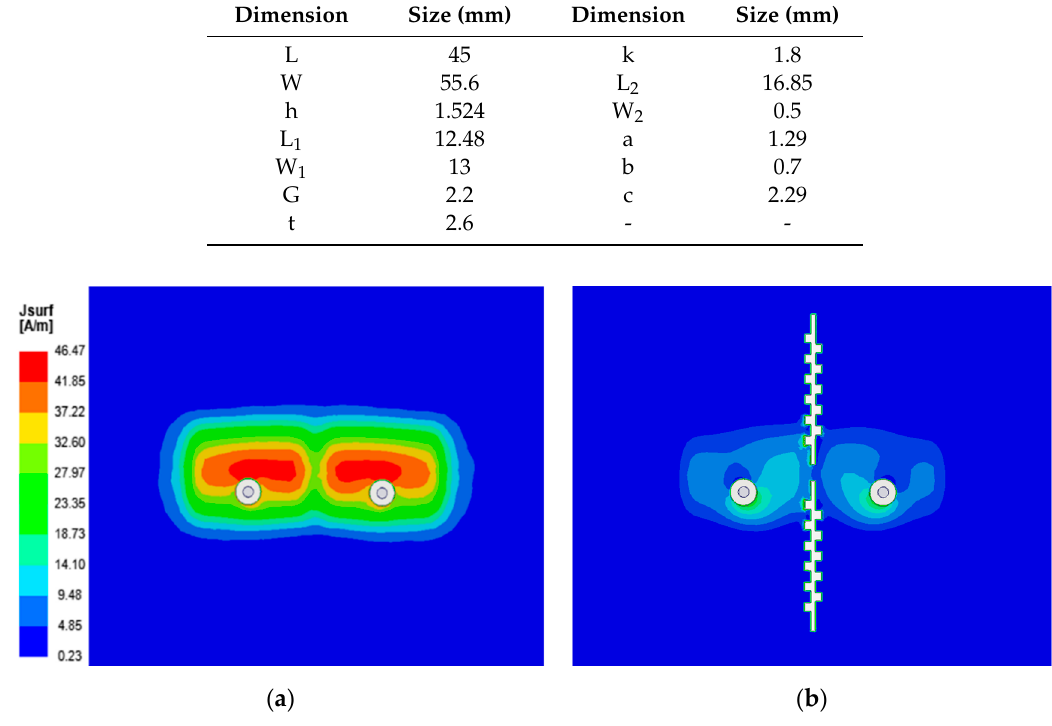
( b ) Figure 12. Operation frequency at 5.8 GHz. The radiation pattern of MIMO antenna with and without DGS. ( a ) E plane; ( b ) H plane. 4. Measurement Results and Discussion As previously discussed, by using the electromagnetic simulation tool, HFSS, the performance of designed DGS in a MIMO antenna has been carried out, in terms of working bandwidth, reflection coefficients, mutual coupling, radiation pattern, and gain. This designed MIMO antenna with DGS was fabricated in our laboratory and must be checked in experiment. A photograph of the sample is shown in Figure 16, together with the microwave chamber and antenna test system. The overall size of this antenna is W × L × h = 55.6 × 45 × 1.524 mm. Other dimensions in Figure 2 and the preferred physical sizes as selected in the above discussion are listed in Table 1.